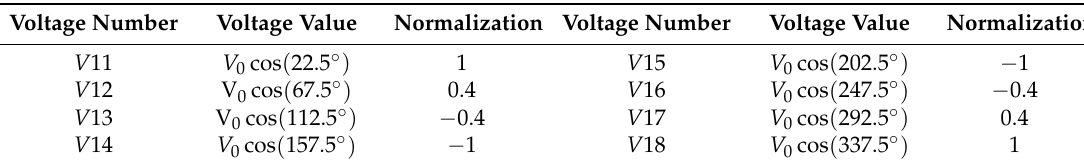
Table 1. The voltages distribution of the dipole sound field excited along the x -axis for the longitudinally vibrating piezoelectric elements (LVPEs).